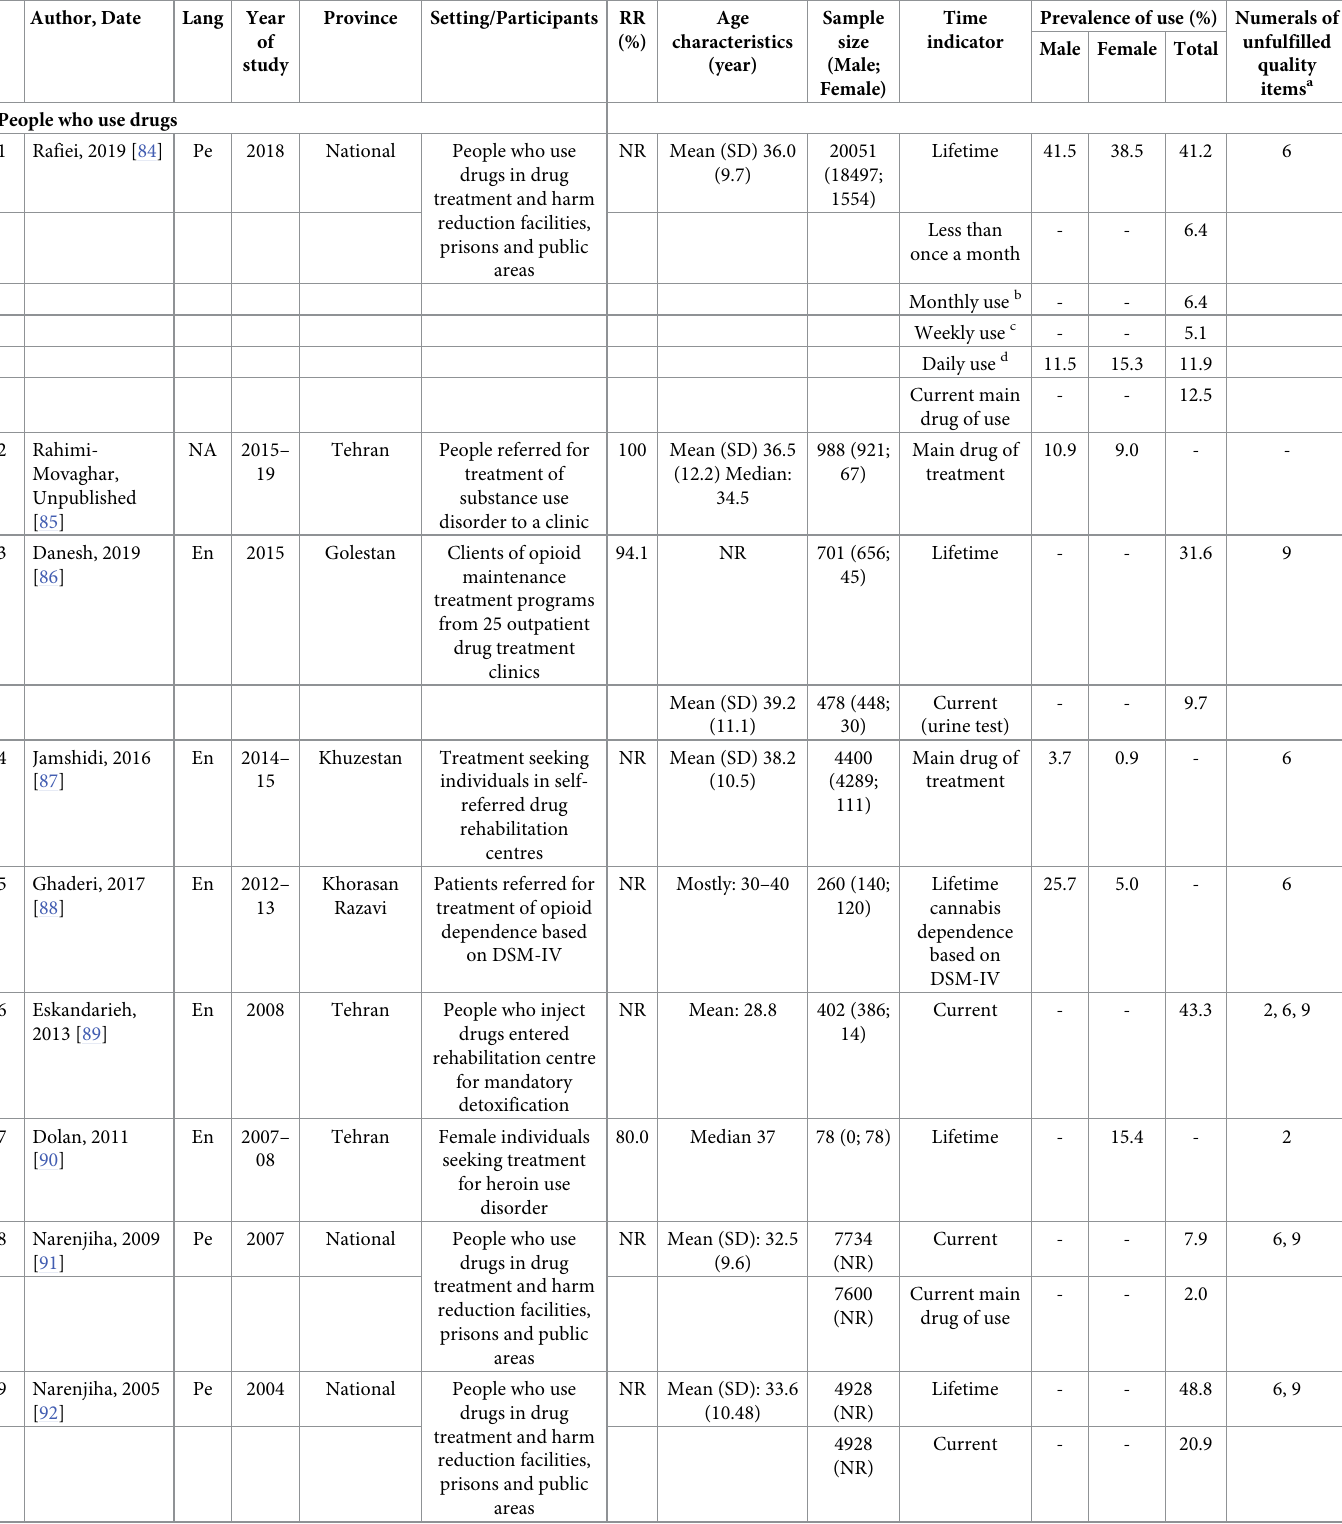
Table 4. Characteristics and results of studies on the prevalence of cannabis use and use disorder among the high-risk populations. Author, Date